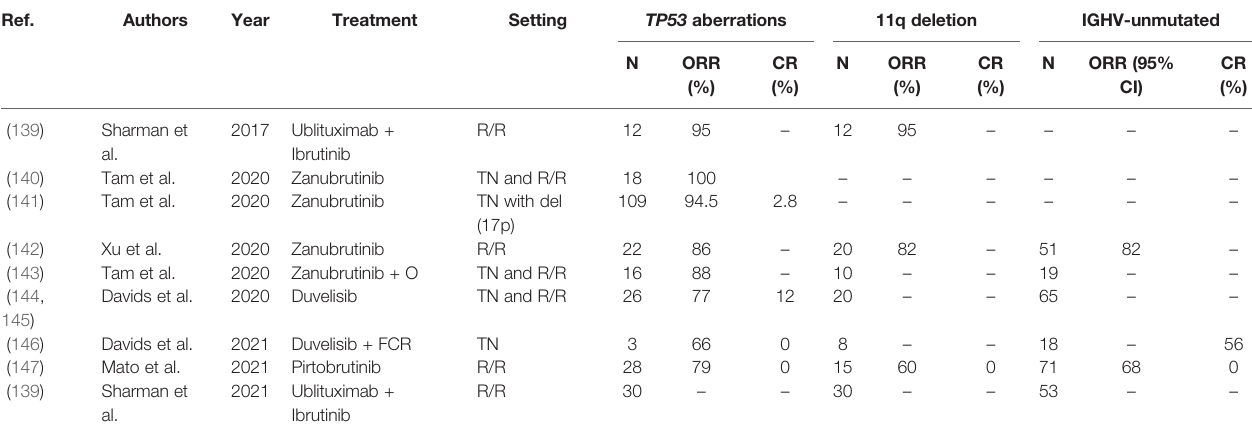
TABLE 10 | An overview of phase 1 and 2 trials of new drugs according to high-risk CLL subgroups.